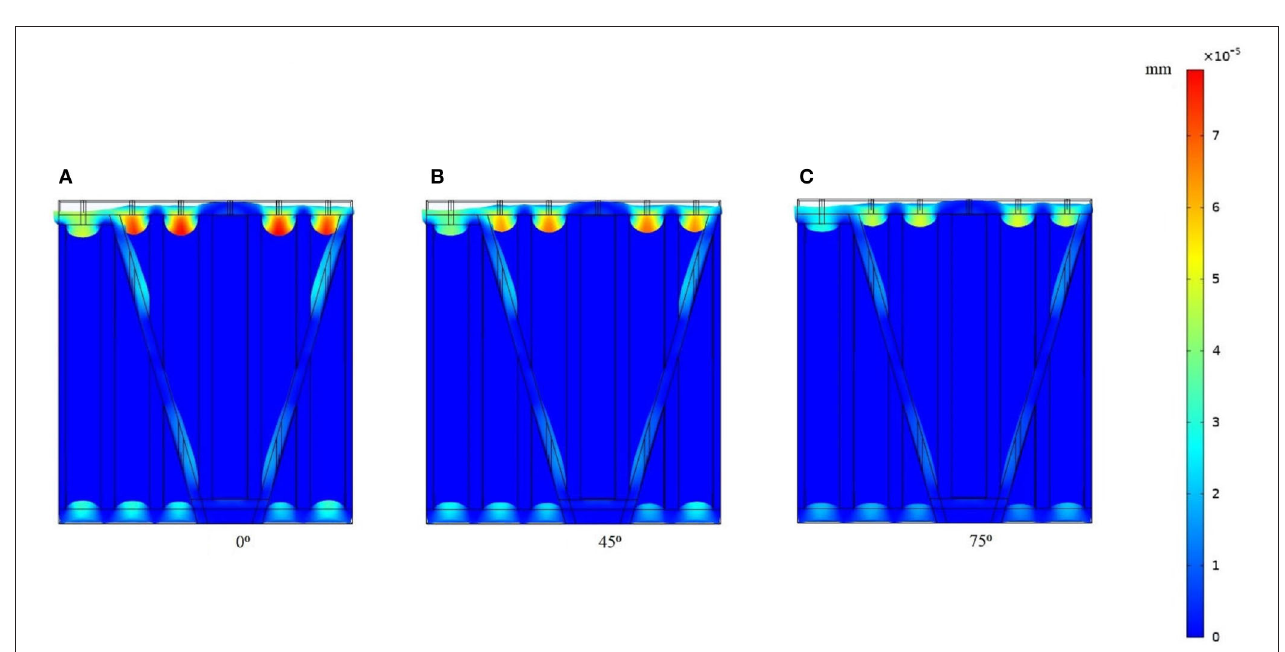
FIGURE 10 | Structural deformation at 500 Hz under the incidence angles as (A) 0 ◦ , (B) 45 ◦ , and (C) 75 ◦